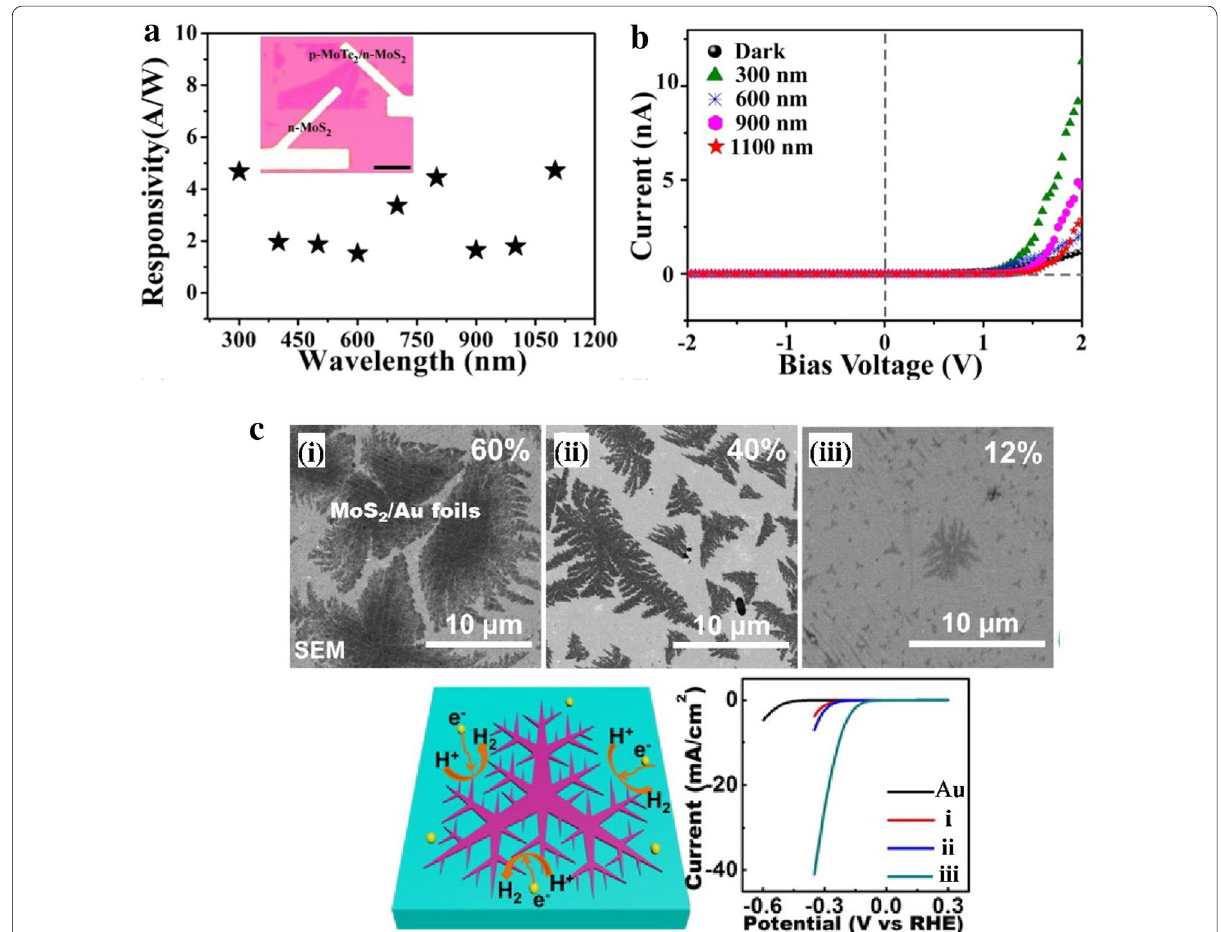
Fig. 6 Optoelectronic properties and electrochemical catalysis applications of TMDs materials. a Spectral responsivity curve of the MoTe 2 /MoS 2 heterostructures b I–V curves of the phototransistor device [89]. Copyright 2018, Elsevier B.V. c SEM images of different coverages of dendritic MoS 2 and their polarization curves [95]. Copyright 2014, American Chemical